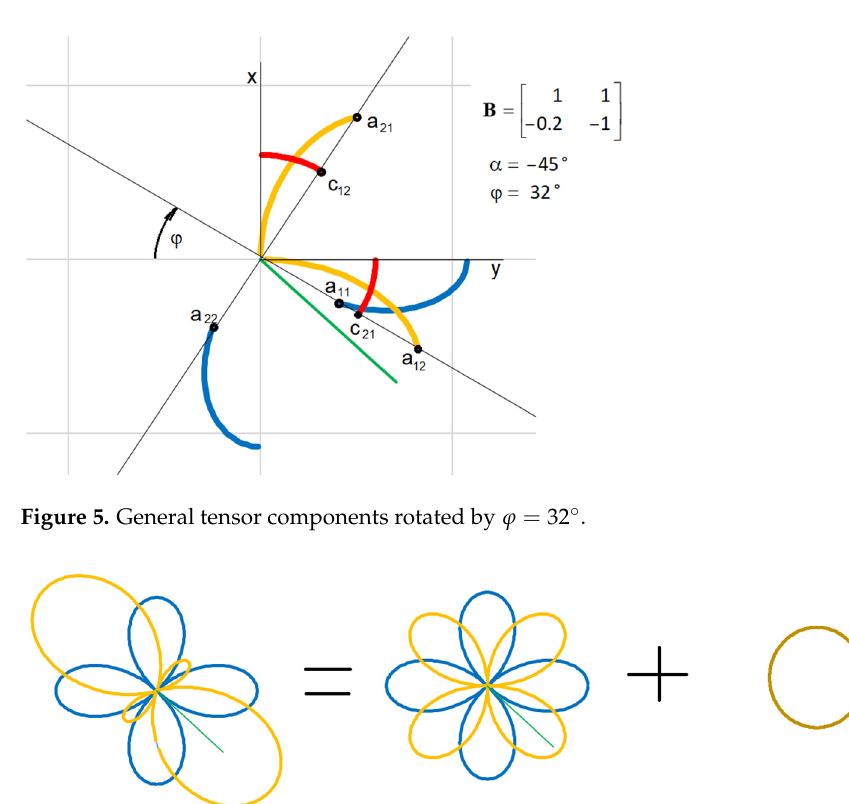
Figure 6. General tensor is a product of symmetric and antisymmetric tensors, using parameters in Figure 7. Figures 7–10 show glyphs representing various general tensor values.